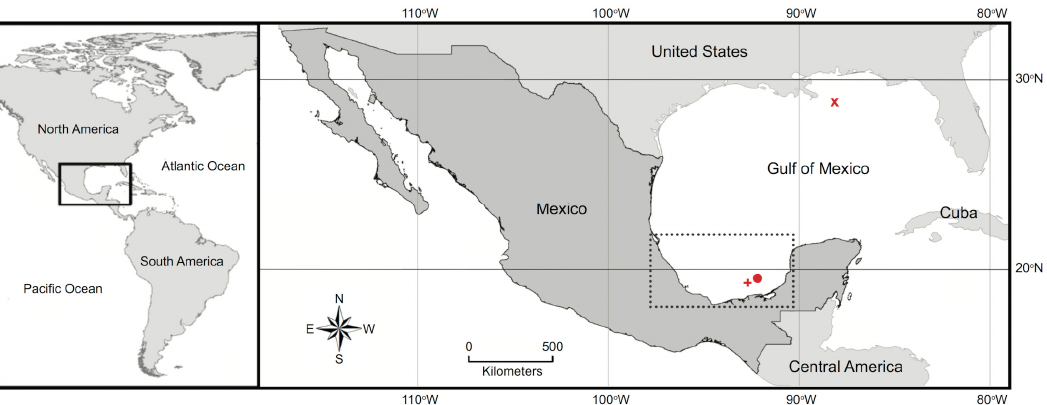
Figure 1. The location of Campeche Bay (dotted box). The position of the Cantarell Oil Seep (dot), Ixtoc-1 platform (+), and the Deepwater Horizon well (x) are also shown. Courtesy of Adriano Vasconcelos (LabSAR/LAMCE/PEC/COPPE/UFRJ).